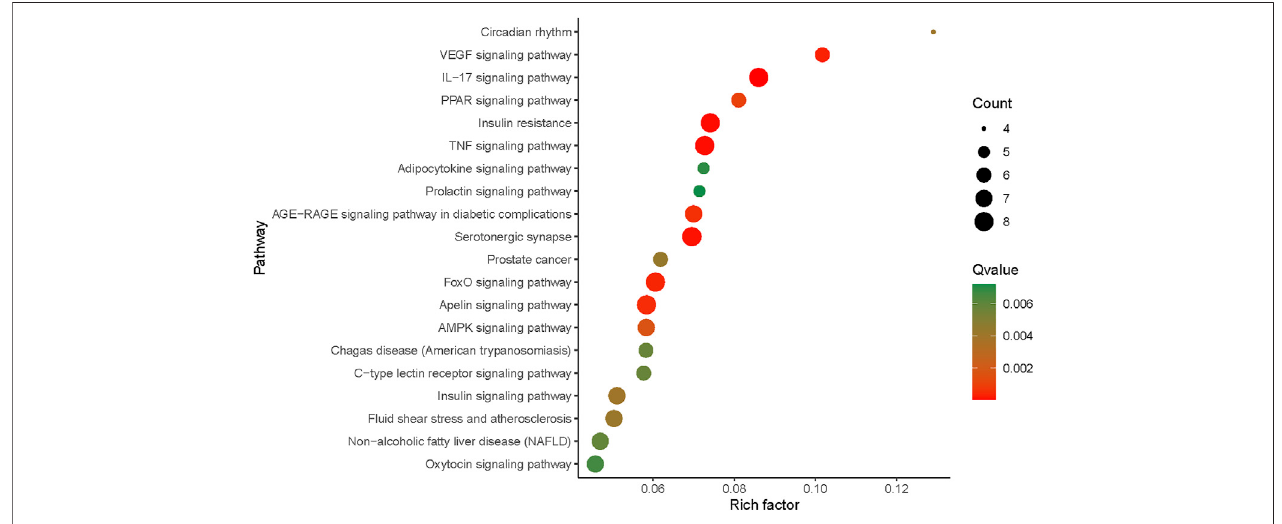
FIGURE 6 | KEGG mechanism